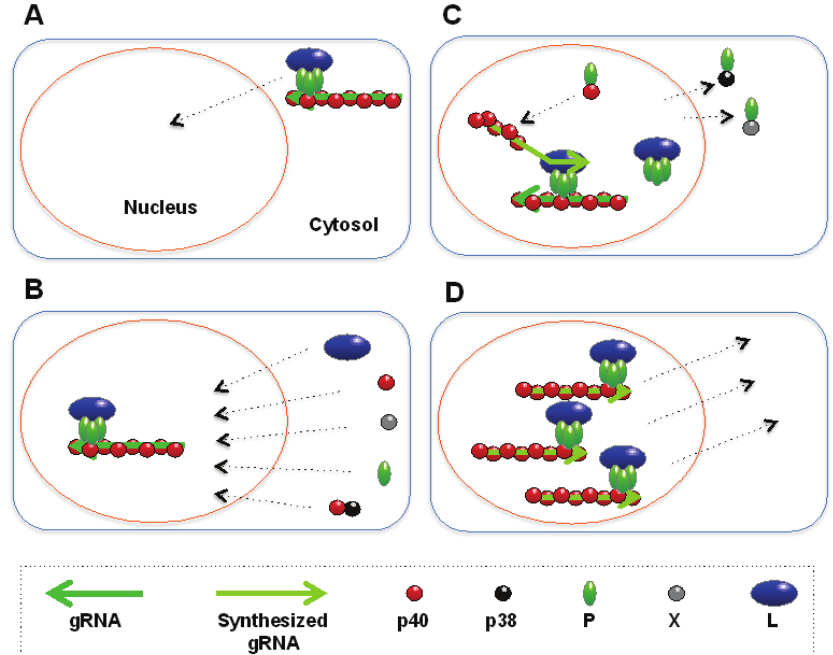
Figure 2. Nuclear import and export events in the BDV replication cycle. ( A ) Nuclear import of the incoming BDV RNP. BDV RNPs translocate into the nucleus via NLSs at their surface. ( B ) Nuclear import of viral RNP components after translation of BDV mRNA transcribed from BDV RNP. Most of the RNP components, except for p38, translocate into the nucleus mediated by their bona fide NLSs; p38, which lacks an NLS, translocates into the nucleus with the help of p40. ( C ) Replication of BDV RNP in the nucleus. In the nucleus, P forms two complexes: the N 0 -P and P-L complexes. Upon replication, a nascent gRNA binds to N 0 , displacing P. The stoichiometry of N-to-P is tightly regulated for efficient replication through nuclear export mediated by the binding of P with p38 and X (see Section 3.2). ( D ) Nuclear export of newly synthesized BDV RNP. The nascent RNPs are exported by unknown mechanisms, perhaps mediated by p38, P or M (see Section